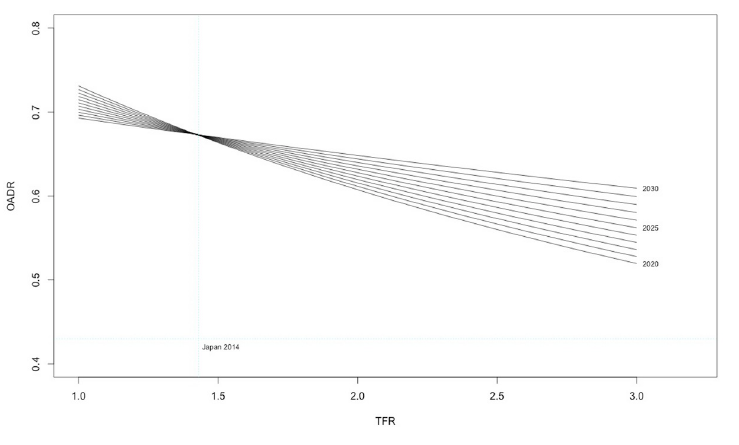
Fig 2. Fertility model